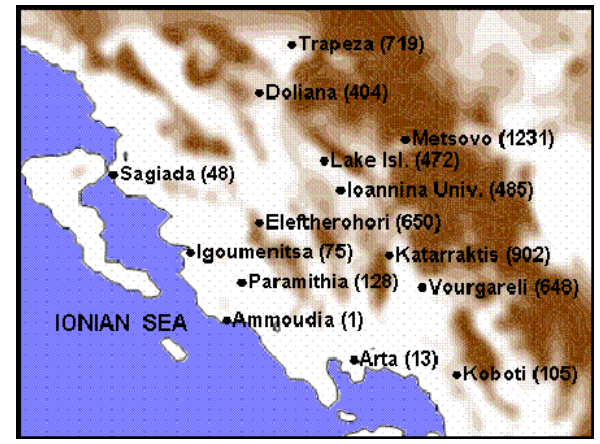
Fig. 2. Automatic meteorological stations in Epirus (altitudes in meters).